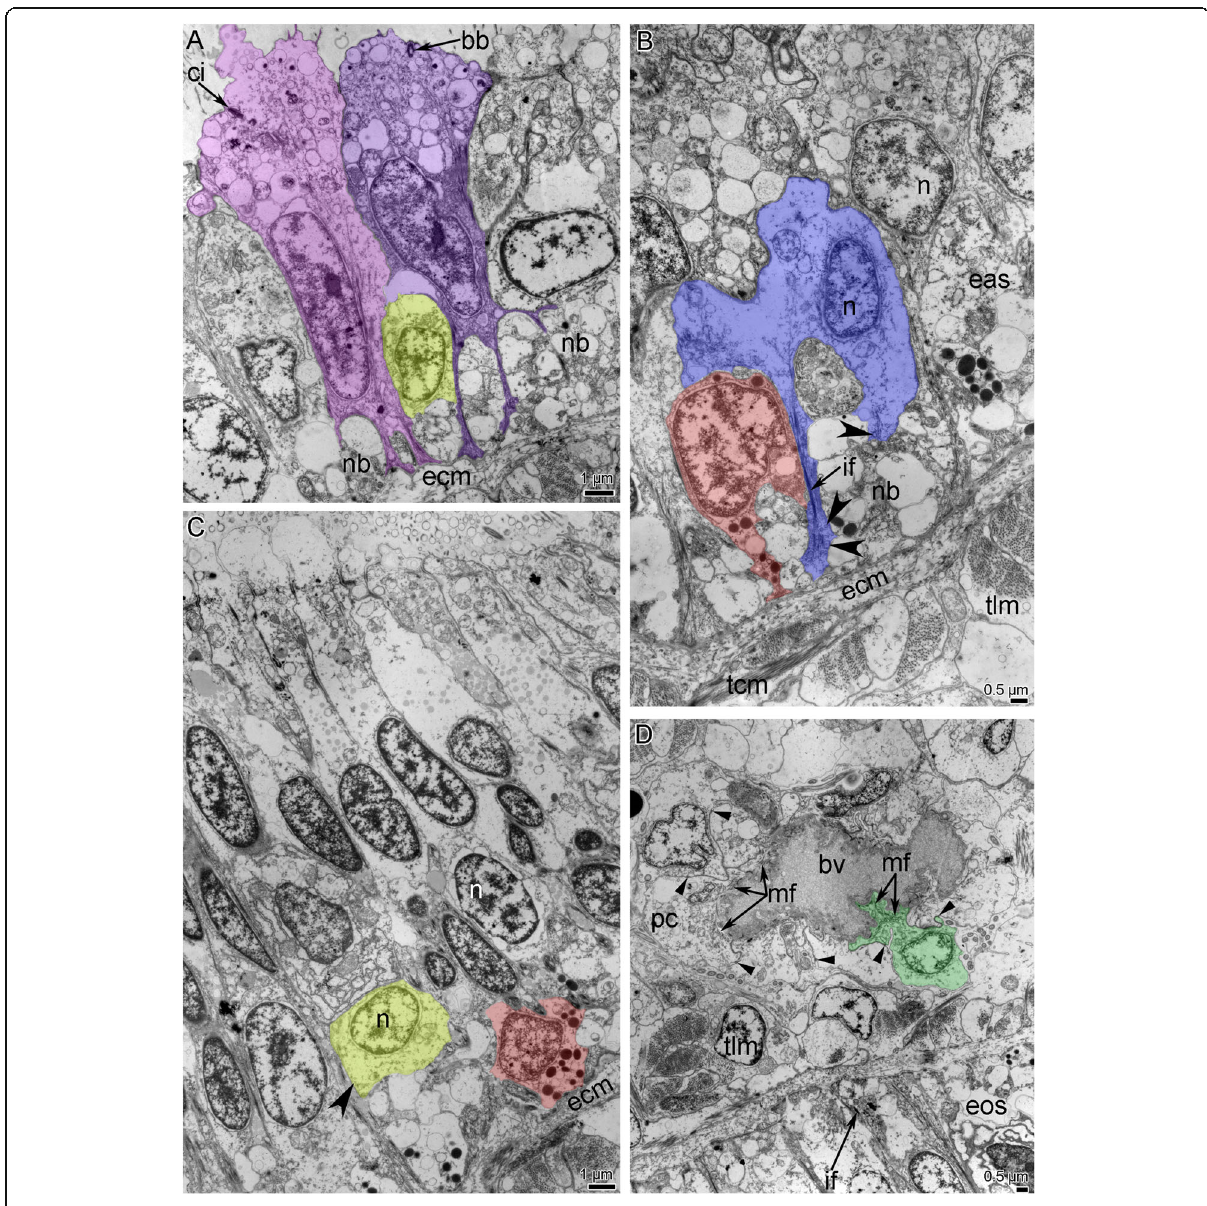
Fig. 4 Ultrastructure of tentacle nerves and blood vessel of Owenia borealis (TEM). A Epithelium of aboral side: different types of cells. Two supportive cells are shown by different colors; perikaryon is shown in yellow. B The base of epithelium of aboral side: two types of glial cells are shown by red and blue. Vesicles in glial cell are indicated by concaved arrowheads. C Epithelium of oral side with perikaryon (yellow) and glial cell (red). Vesicles in perikaryon are indicated by concaved arrowheads. D Myoepithelial cells (green) of coelomic lining, which form the wall of blood vessel. Adherence junctions between cells are indicated by straight arrowheads. Abbreviations: bb – basal body; bv – blood vessel; ci – cilium; ecm – extracellular matrix; eas – epithelium of aboral side; eos – epithelium of oral side; if – intermediate filaments; mf – myofilaments; n – nucleus; nb – neurite bundle; pc – peritoneal cells; tcm – tentacle transverse muscles; tlm – tentacle longitudinal